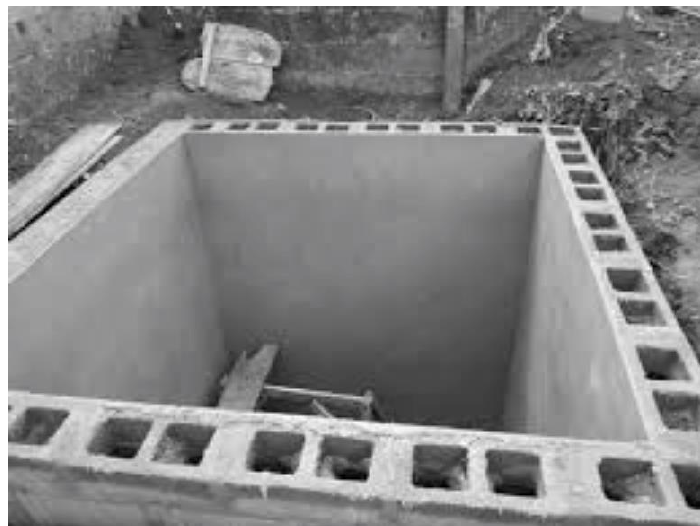
Fig. 2. A typical Septic tank construction in